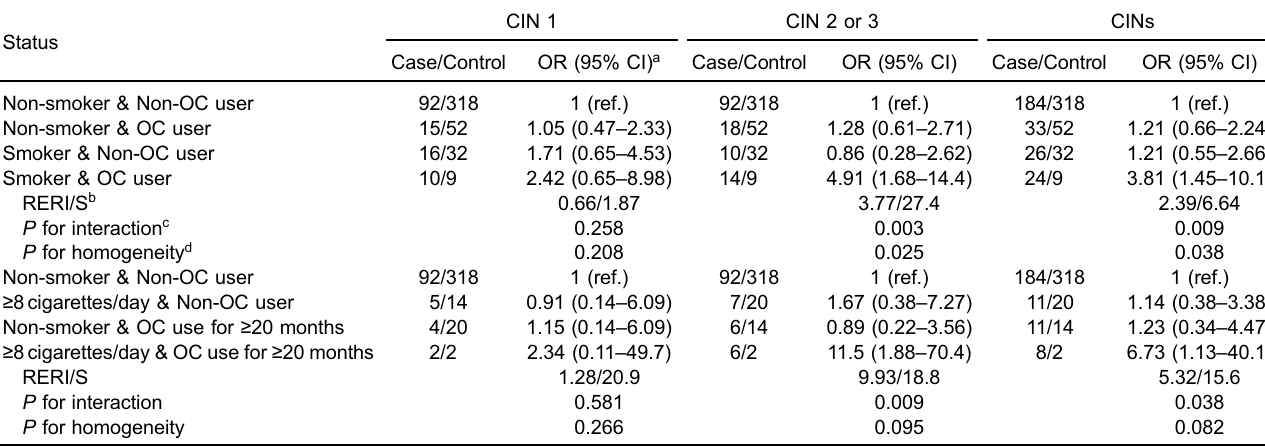
Table 3. Odds ratios of combination of oral contraceptive use and smoking status for cervical intraepithelial